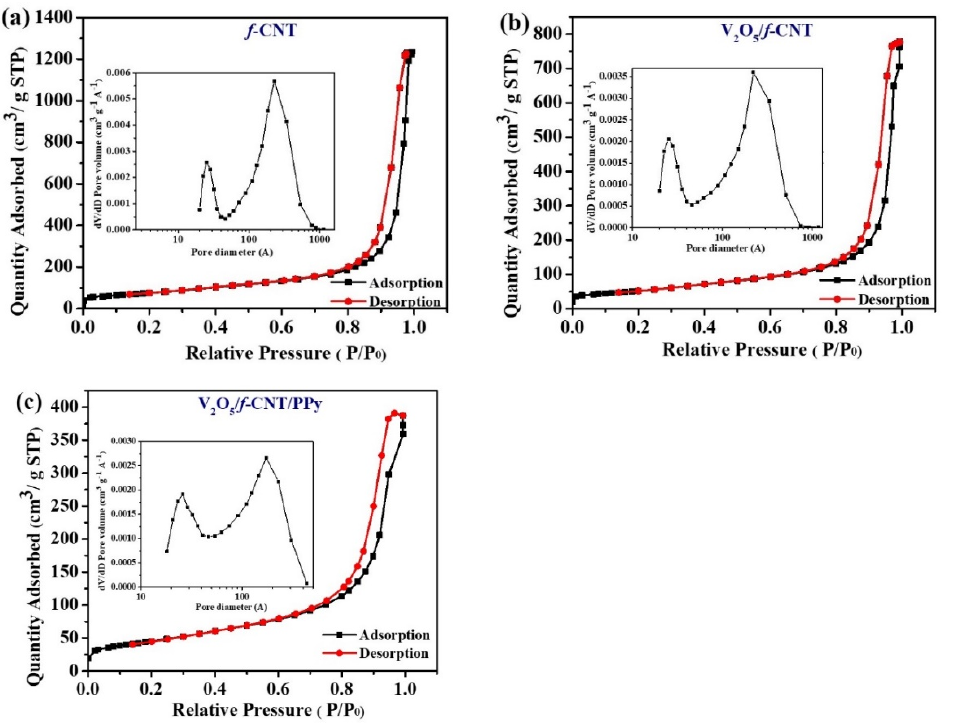
Figure 8. Nitrogen adsorption/desorption isotherms of ( a ) f -CNT, ( b ) V 2 O 5 / f -CNT, and ( c ) V 2 O 5 / f -CNT/PPy inset: pore size distribution curves.